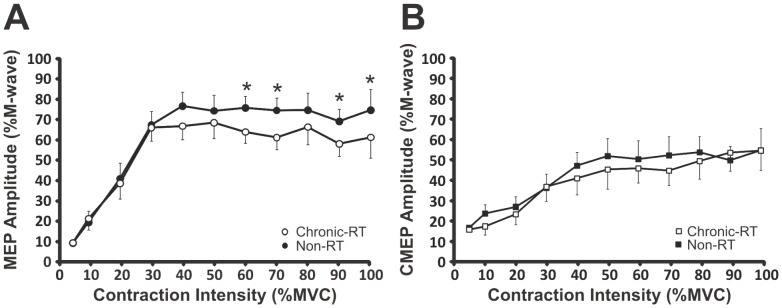
Between group differences in corticospinal responses (A) MEPs and (B) CMEPs of the biceps brachii during elbow flexion from 10-100% MVC.Each data point represents group means ± SE. * Indicates a significant (p≤0.043) difference between groups.